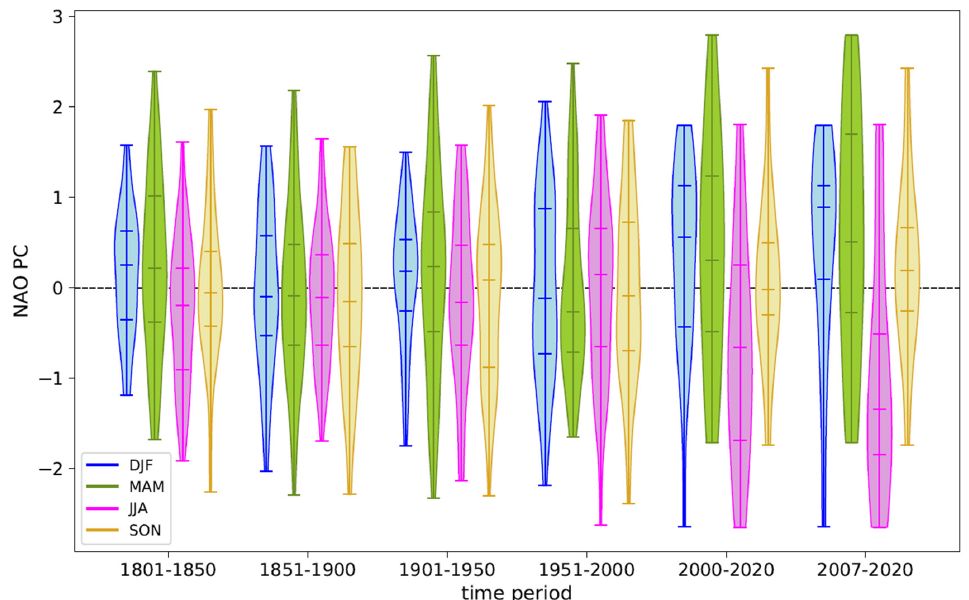
Figure 8. Violin plots showing the distribution of seasonal annual NAO PC values for selected periods. The median and quartiles are shown by horizontal lines, and there is a kernel density estimate of the sampling distribution.